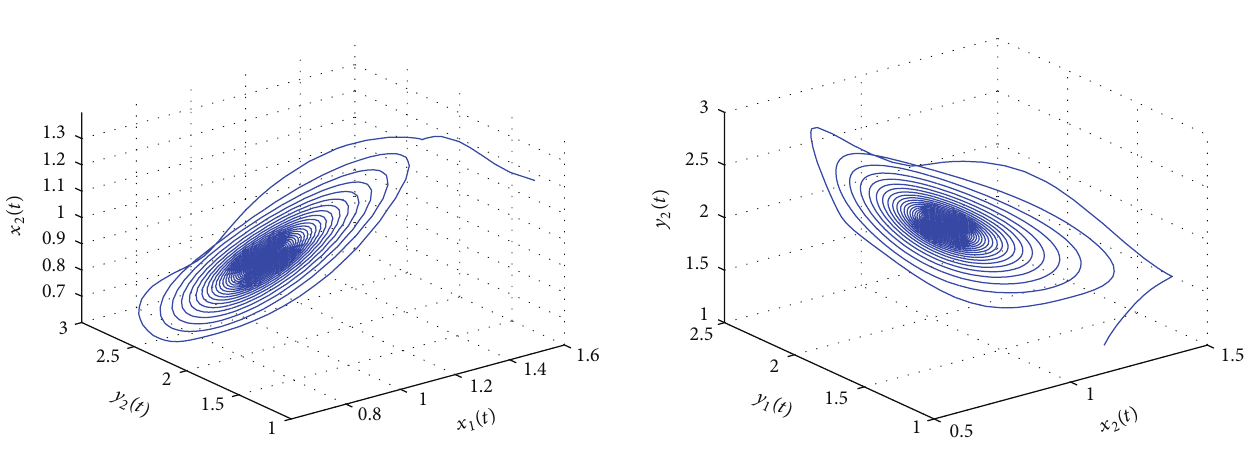
Figure 21: The phase plot of the states 𝑥 2 , 𝑦 1 , 𝑦 2 for 𝜏 2 = 5.5500 < = 6.6494 and 𝜏 ∗ = 2.5000 𝜏 ∗ 2 1